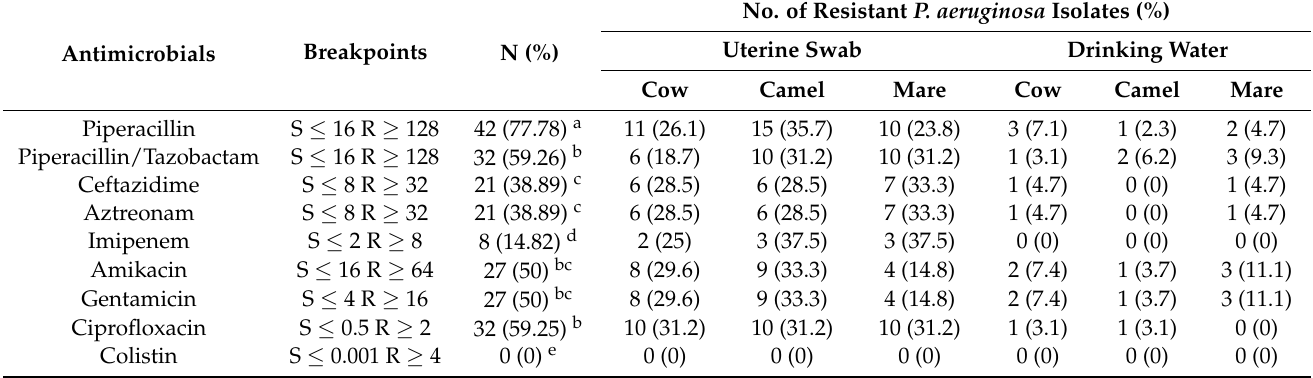
Table 3. The antimicrobial-resistant profiles of P. aeruginosa ( n = 54) isolated from cow, camel, mare, and drinking water.